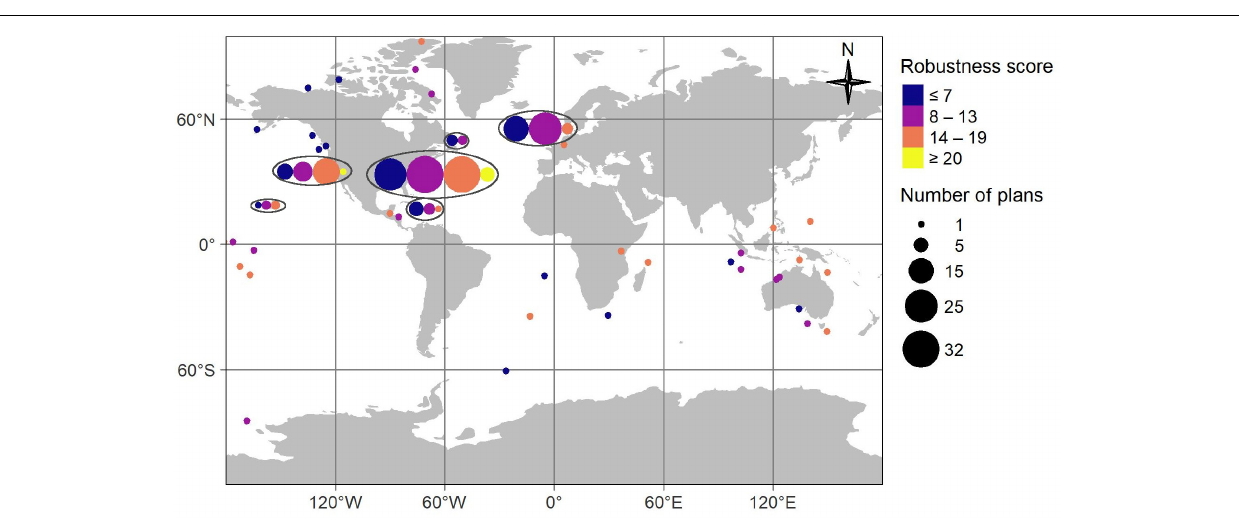
FIGURE 6 | Climate change robustness scores for the manually reviewed climate-considering MPA management plans ( n = 223). Robustness scores for management plans ranged from 0 to 23; a perfect score was 28. Circle area represents the number of management plans that obtained a robustness score within one of four score categories. Plan locations are approximate as circles have been jittered to avoid overlap. In geographic areas with high management plan density, the number of plans that obtained a given robustness score was summed and plotted in the middle of that geographic area for ease of visualization (Atlantic